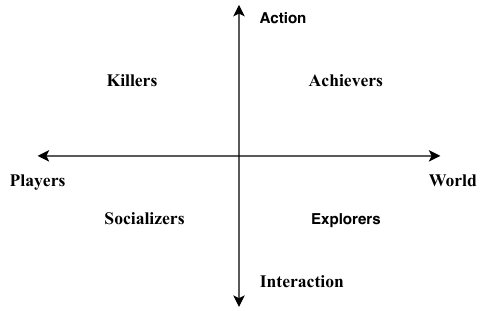
Figure 1. Bartle taxonomy in two dimensions (Source: